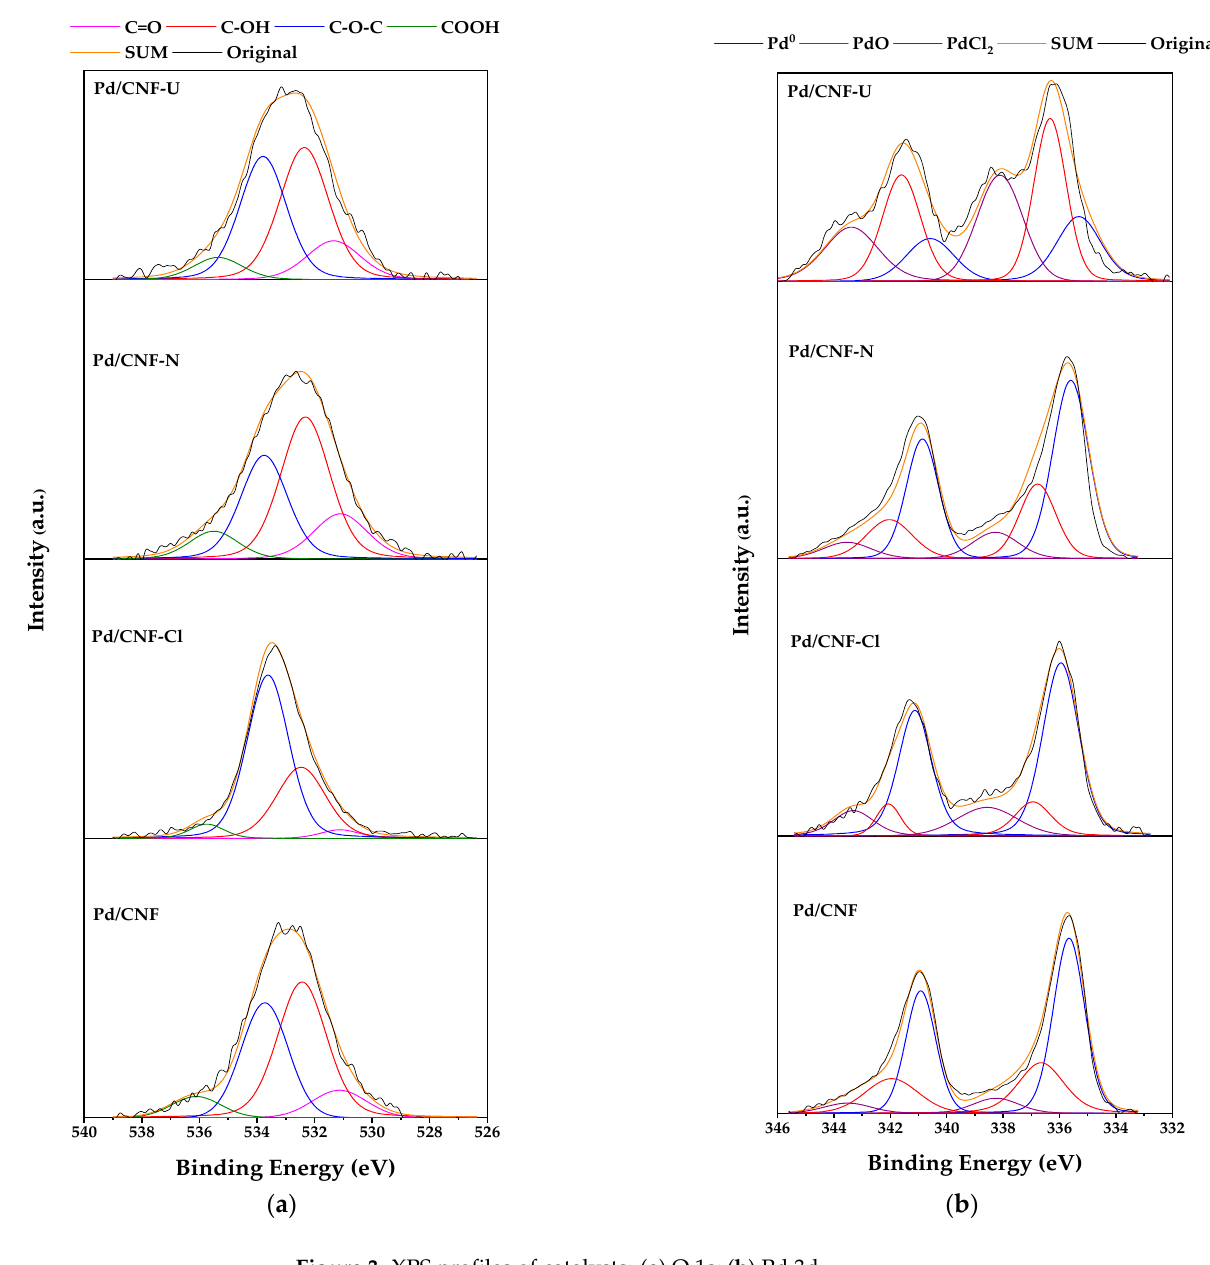
Figure 3. XPS profiles of catalysts: ( a ) O 1s; ( b ) Pd